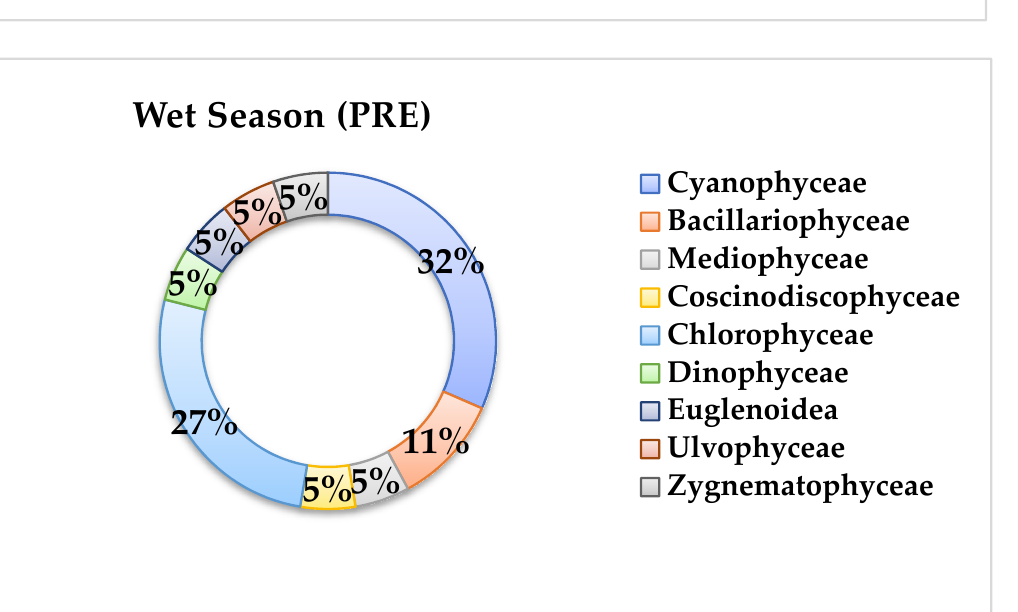
Figure 5. Percentage composition of phytoplankton during the dry and wet seasons in the